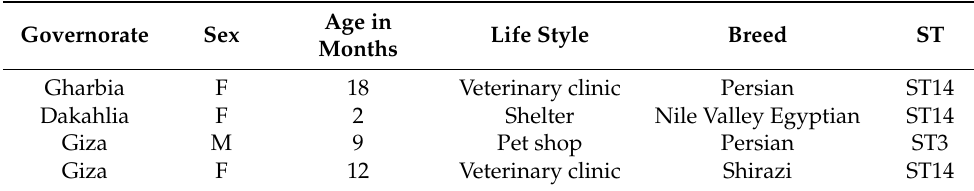
Table 3. Data on infected cats with Blastocystis sp. in